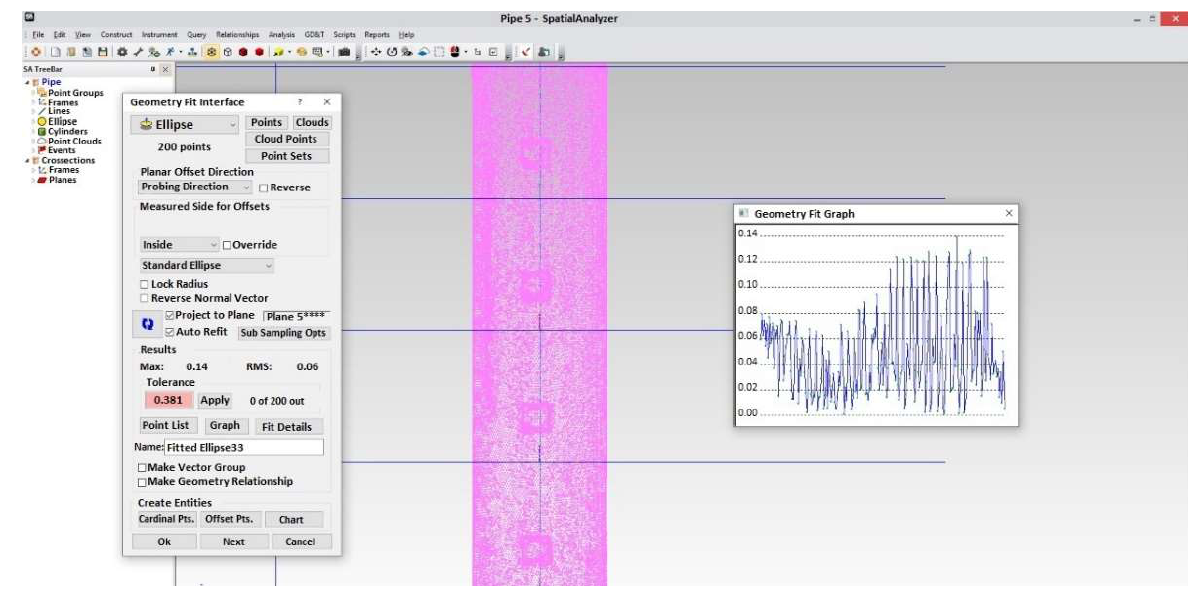
Figure 16. Interface of the SpatialAnalyzer software when processing a point cloud.